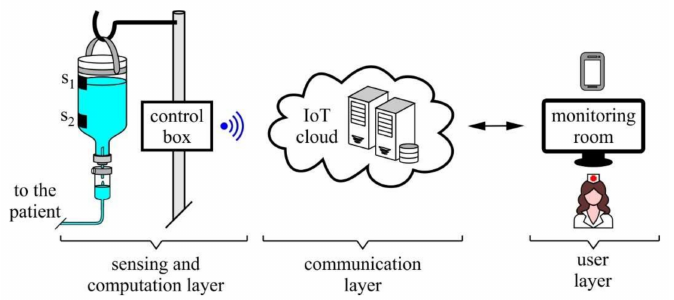
Figure 3. Smart IV infusion dosing system layers.